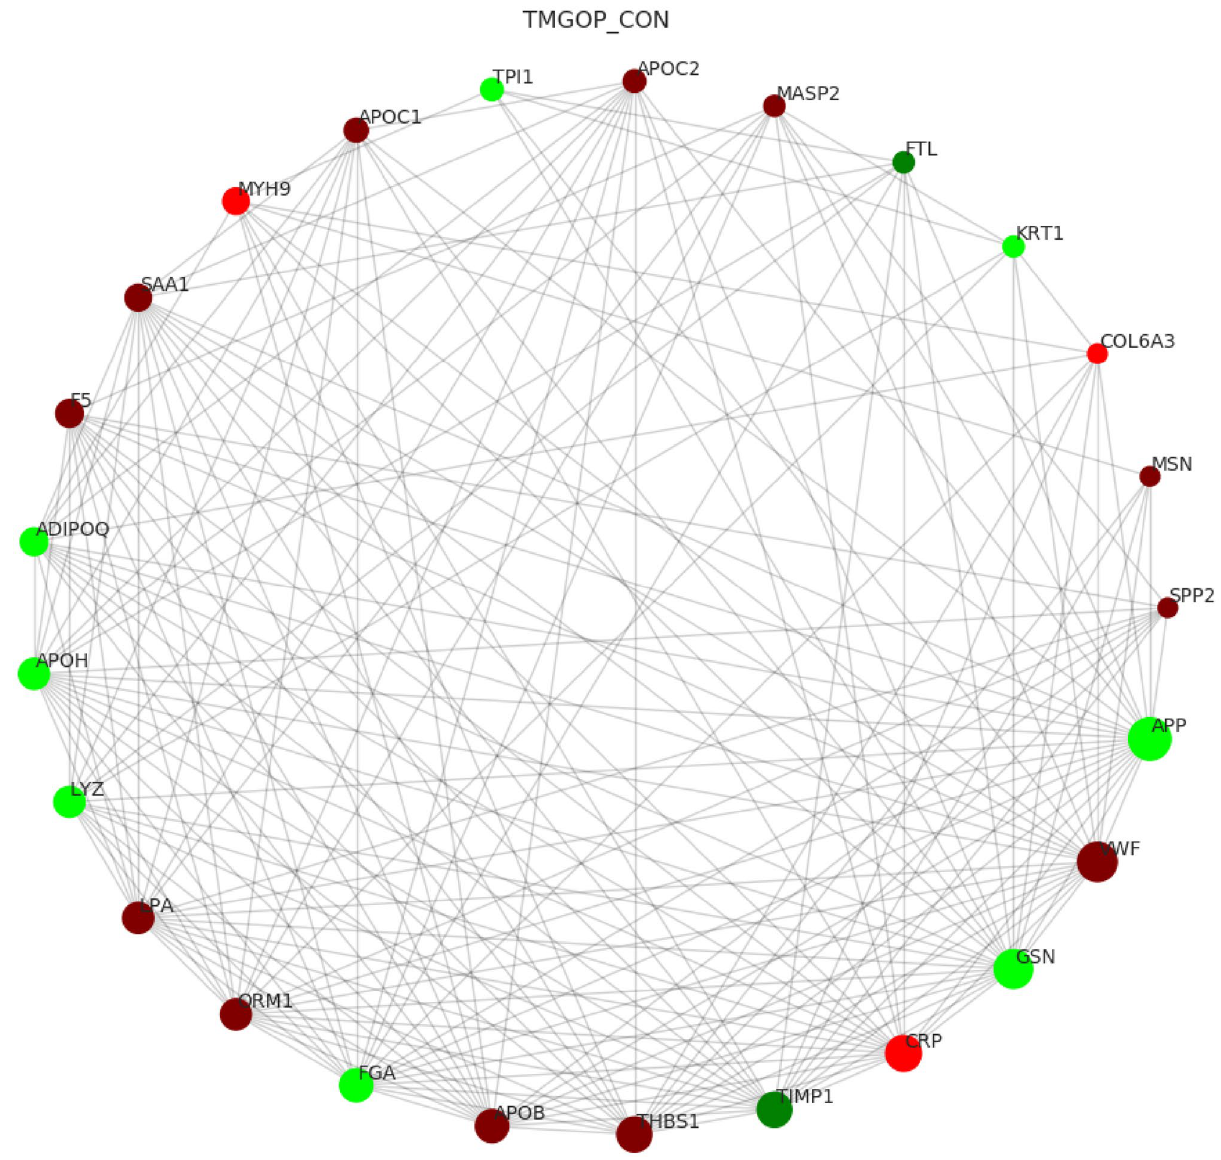
Figure 7. Enrichment KEGG pathway diagram. In the picture, the circle represents the differential protein, the red represents the up-regulated protein, and the green represents the down-regulated protein; the size of the circle represents the degree of connectivity, and the larger the circle, the higher the